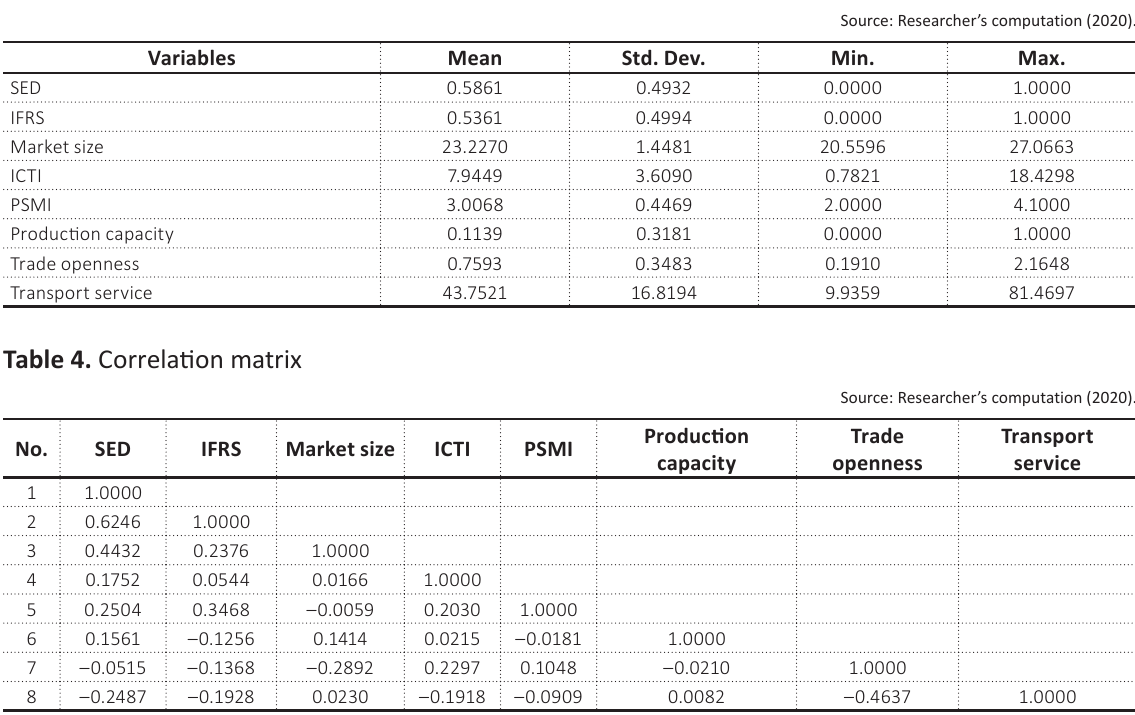
Table 3. Variables statistic (2010–2018)